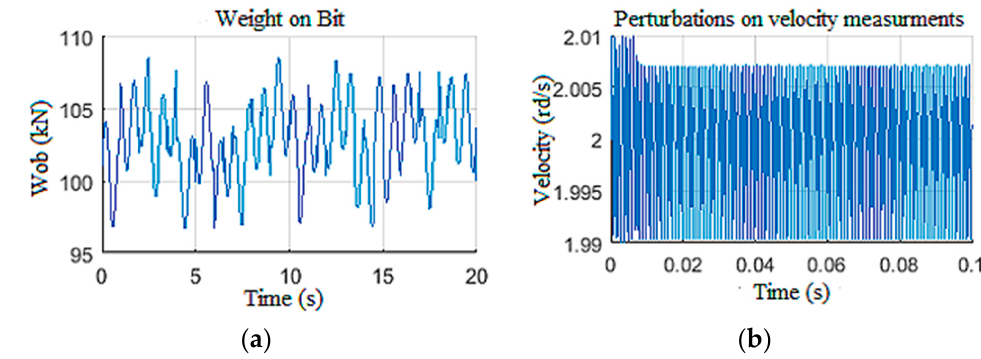
Figure 27. Disturbances on LQG inputs: ( a ) Wob; ( b ) induced perturbations.